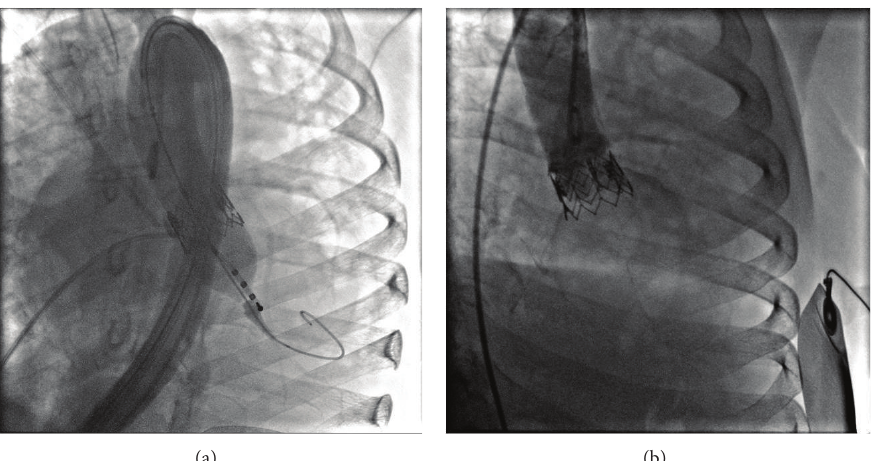
Figure 3: (a) Transcatheter aortic valve implantation (Edwards SAPIEN XT 23 mm). (b) Aortography after TAVI procedure. damping pressure) and critical ostial right coronary artery (RCA) disease (Figure 2). Severe, diffuse calcification of